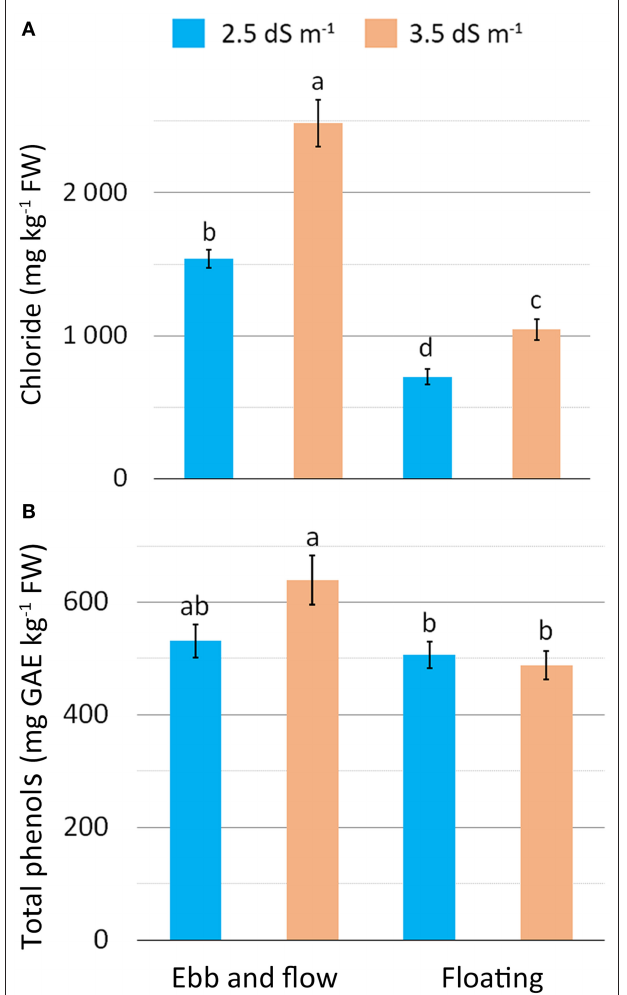
FIGURE 4 | Effect of soilless cultivation system and nutrient solution electrical conductivity on chloride (A) and total phenol (B) concentration in romaine lettuce grown in a greenhouse during the autumn. Vertical bars indicate ± SE of mean ( n = 9) of the observed values, with different letters significantly different according to the LSD test ( α =